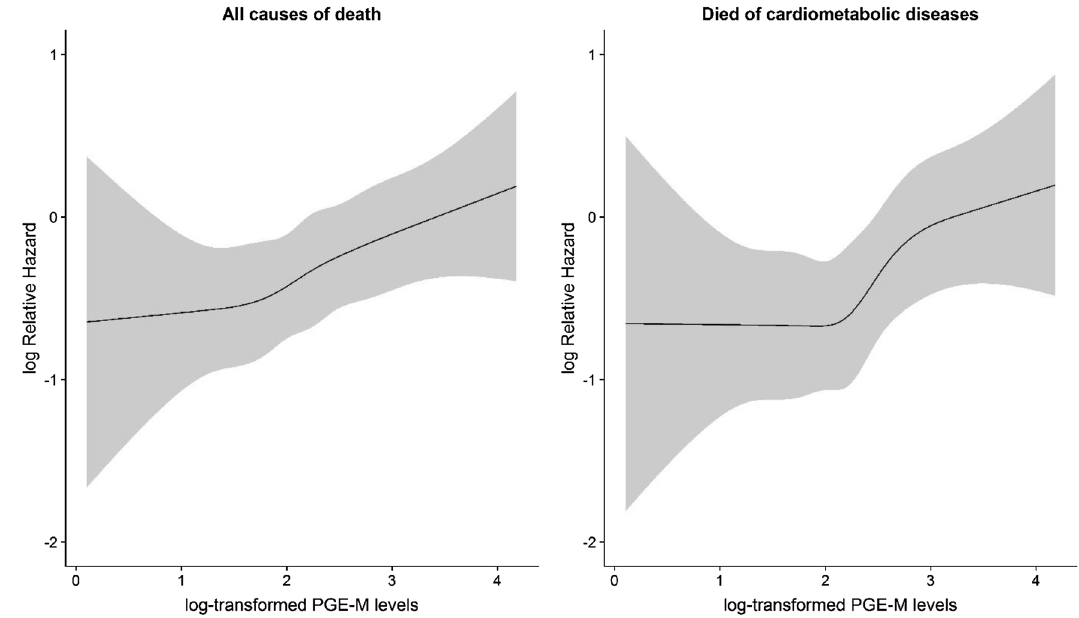
Figure 1. Associations of urinary PGE-M levels with all-cause mortality (left) and death from cardiometabolic diseases (right) using the restrict cubic spline function to account for non-linearity.